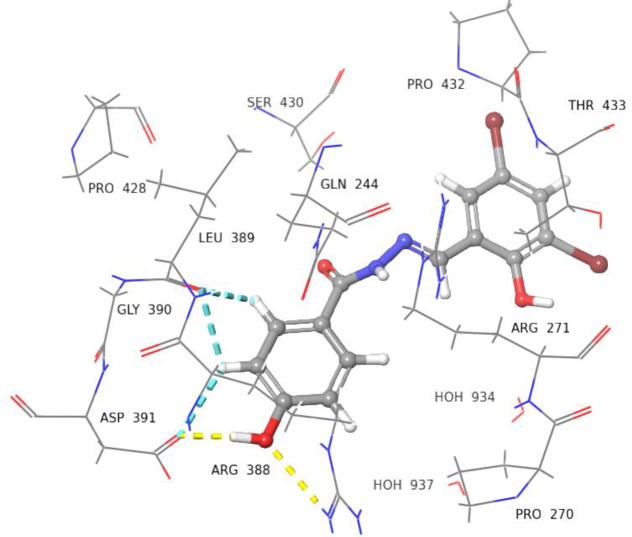
3D Representation of docked pose of compound 22 (IC50 = 6.8 ± 0.7 μM).The OH group is interacting with Asp391 via H-bond (yellow dotted lines), while the hydrogens of phenyl ring are interacting with Leu389 via H-bonds (blue dotted lines).